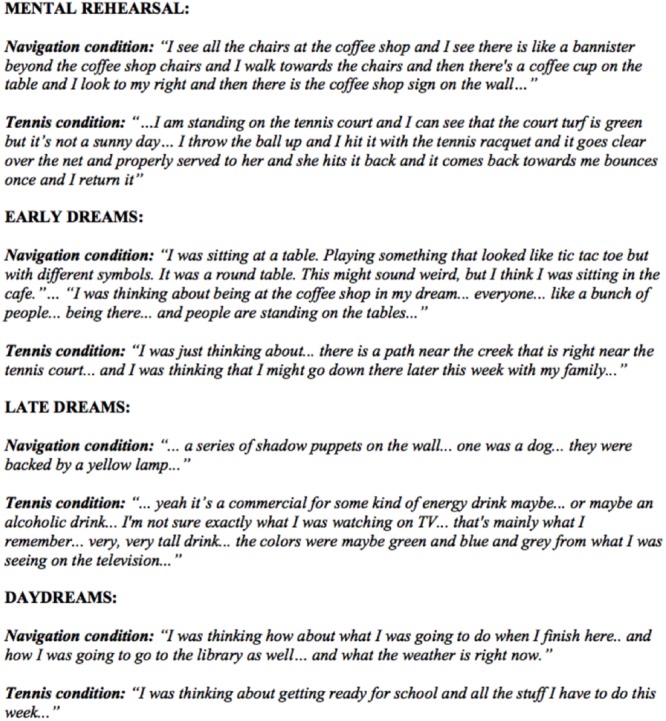
Excerpts from representative examples of wake mental rehearsal, early, late, and daydream reports. Note that in these representative examples, that early dreams contain direct incorporations from the daytime experience of navigating to the goal destinations of the virtual maze (e.g., the café), or the objects in the environment (e.g., a round table), and in another example, mention a tennis court. By contrast, late dreams appear to have incorporations from the lab environment (e.g., references to screens). A description of the lab environment was included in the wake reports to account for non-task specific, but laboratory context-related incorporations. In contrast, the daydream tended to contain preoccupations of the day, rather than incorporations of past task or lab environment elements.